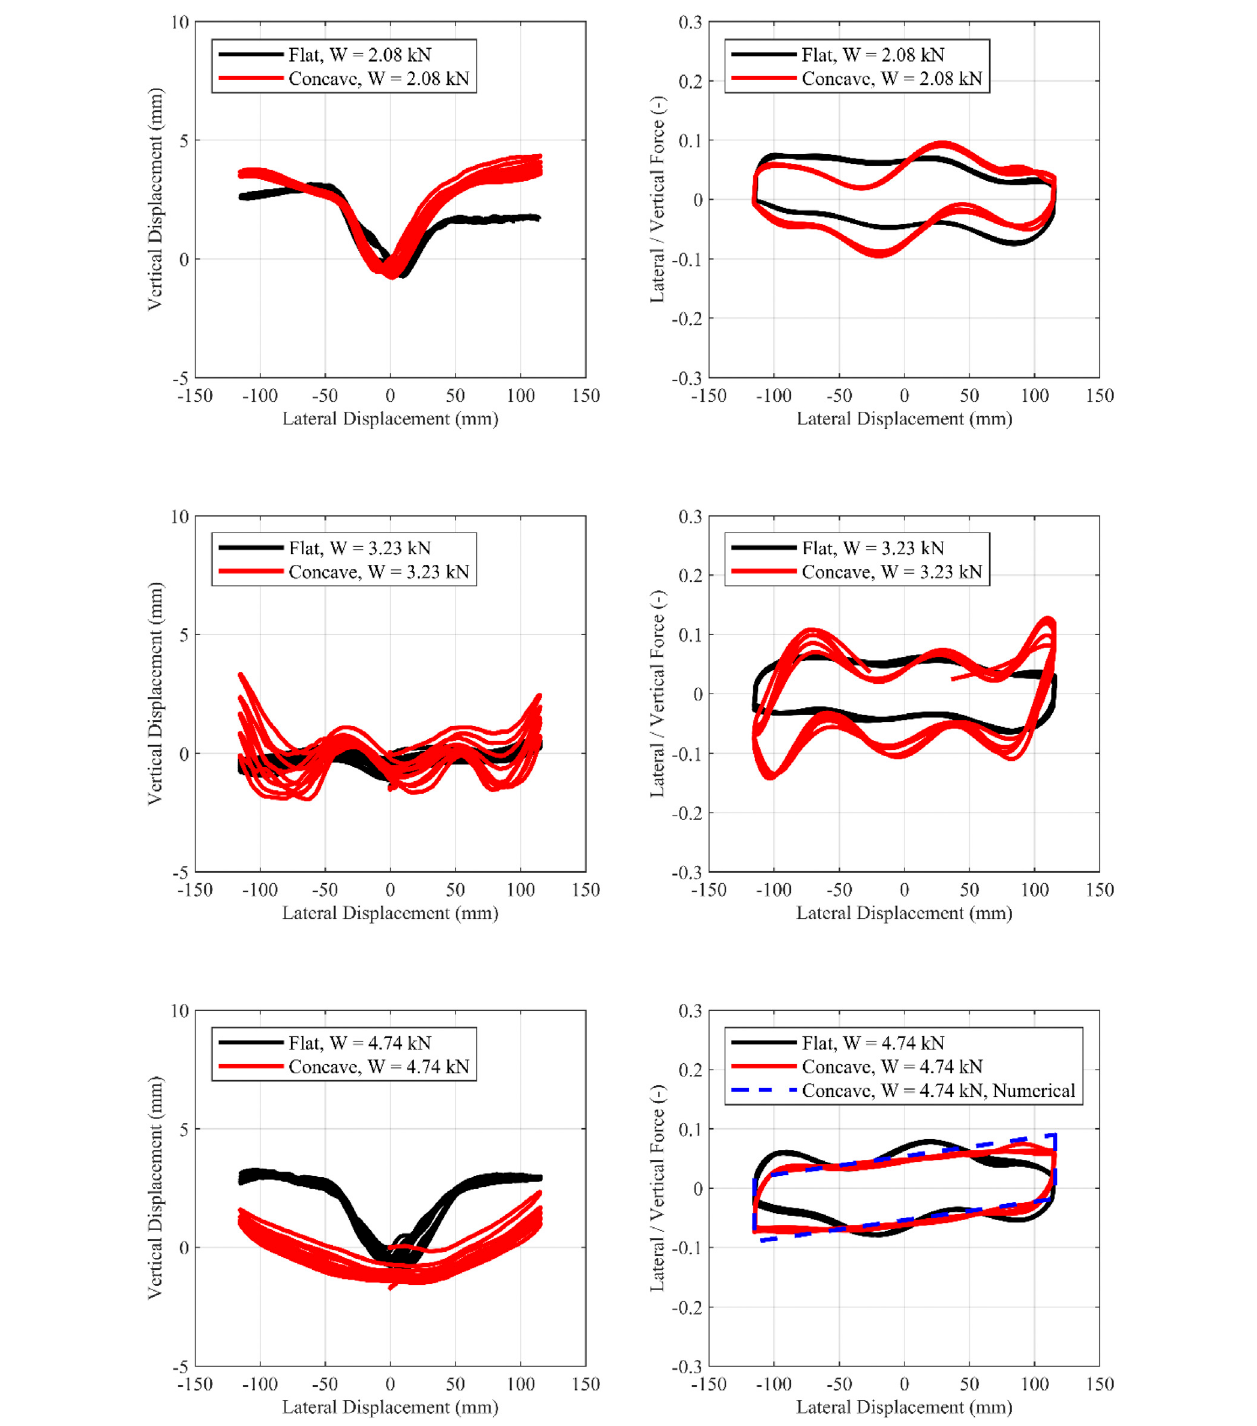
FIGURE 10 | Cyclic motion ± 115 mm. In fl uence of the geometry of the concrete plates. Left , Vertical-horizontal displacement; Right , Lateral/Vertical force — Lateral displacement.